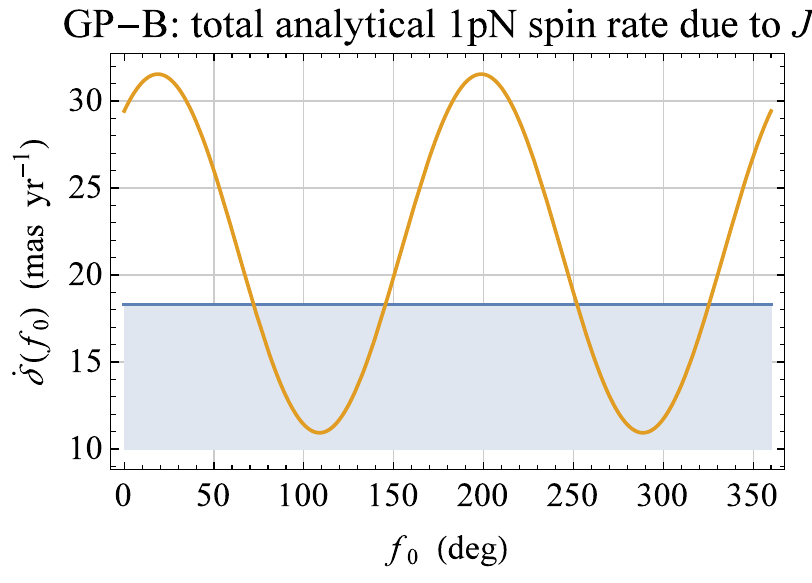
Figure 4. Total (direct + indirect) analytically computed 1pN J 2 -induced rate of change ˙ δ (yellow curve, in masyr − 1 ) of the declination δ of the spin axis of a gyroscope orbiting the oblate Earth as a function of the initial value f 0 of the true anomaly of the gyro’s orbit. We adopted the GP-B’s orbital and spin configuration [25] summarized in Table1, so that, essentially, the plot of Equation(108) is shown. The shaded area, in light blue, is delimited by the GP-B’s experimental mean uncertainty = 18.3masyr − 1 [10,11] in measuring the long-term rates of change of δ . Cfr. with Figure3. σ GP − B ˙ δ It can be noted that the predicted rate is larger than σ GP − B for 0 ◦ ≤ f 0 (cid:46) 70 ◦ , 150 ◦ (cid:46) f 0 ˙ δ